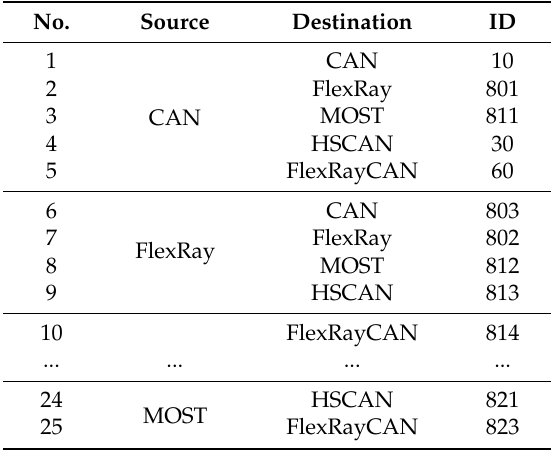
Figure 4. The structure of the In-Vehicle Gateway Module (In-VGM). Table 1. The kinds of message IDs about